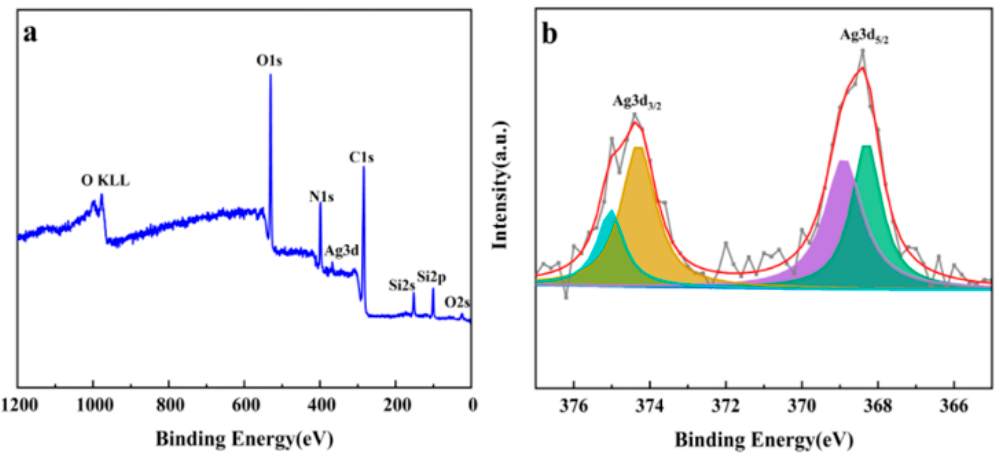
Figure 5. XPS survey spectrum ( a ) and Ag3d ( b ) spectrum of the SF/GEL/KA-N/AgNWs film.